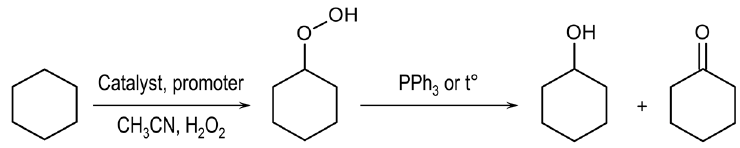
Figure 10. Catalytic oxidation of cyclohexane with H 2 O 2 , catalysed by complexes 1 and 2 .